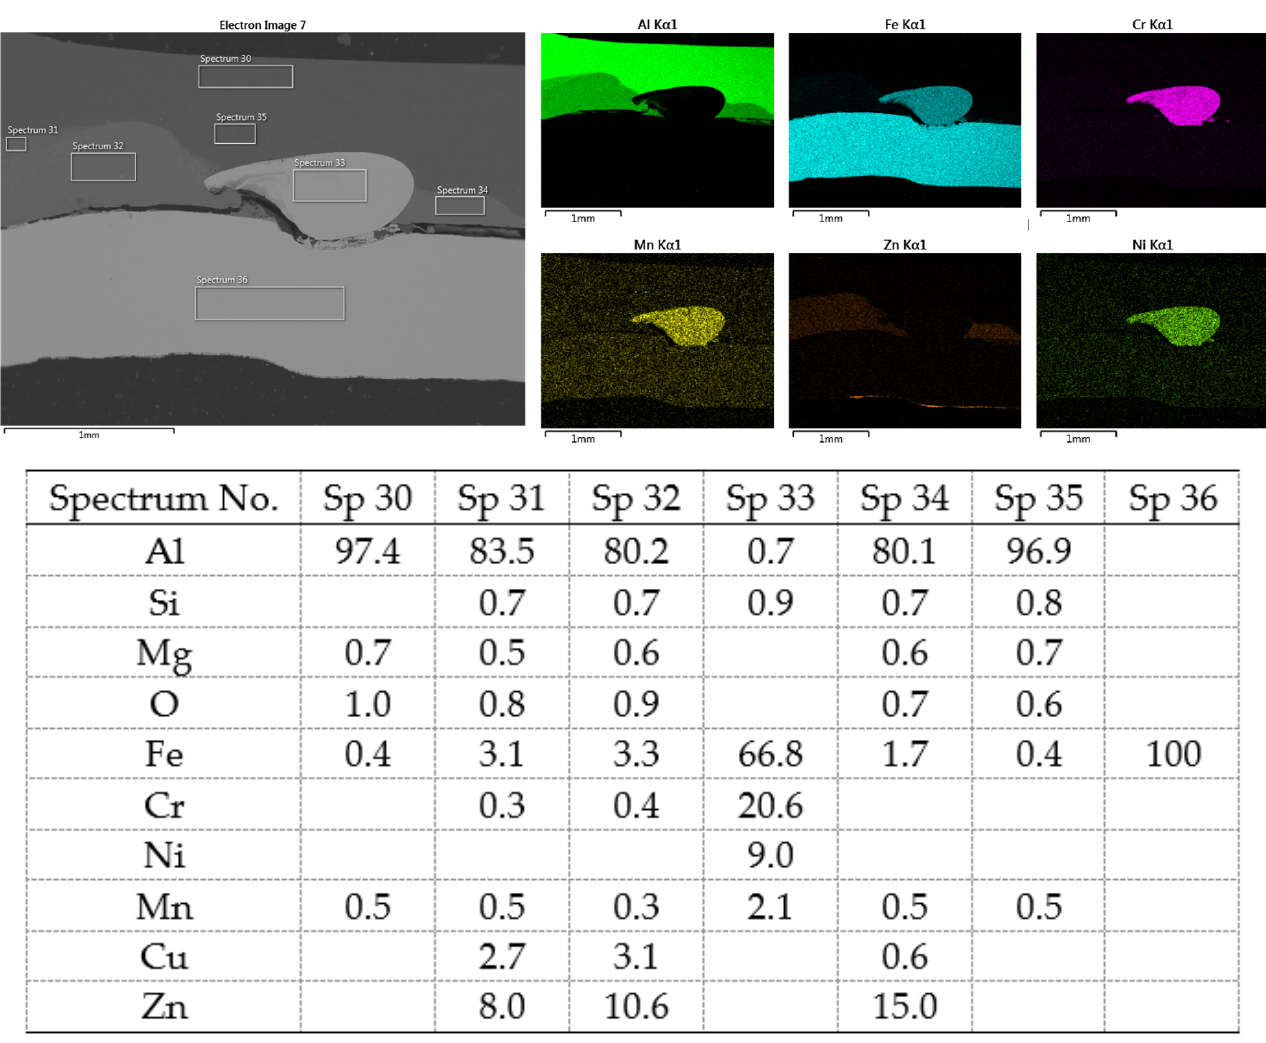
Figure 22. SEM analysis of Al-TL connection, distribution element maps and EDX spectra.